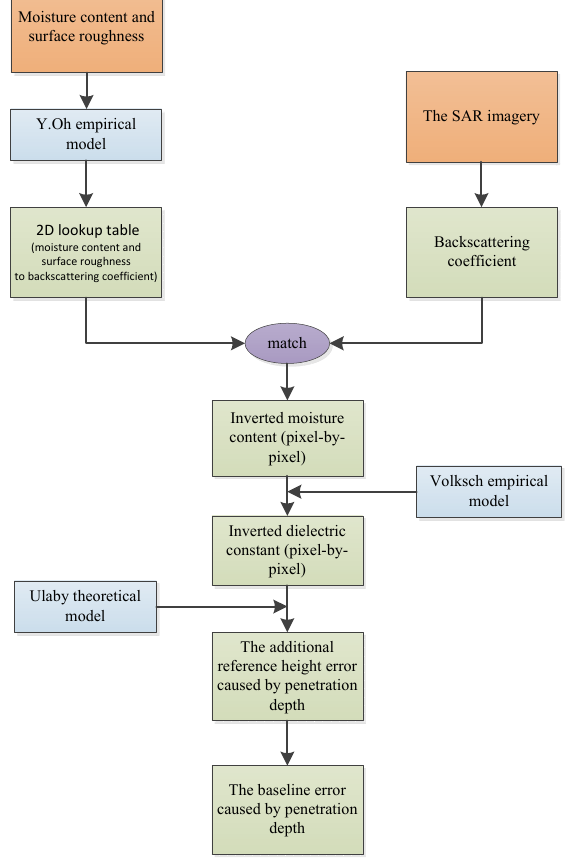
Figure 2. Workflow designed to estimate additional reference height error ∆ h errPen